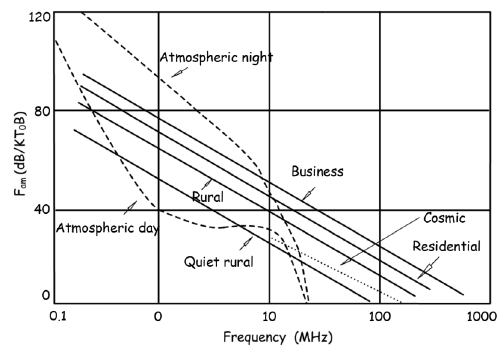
Fig. 10. Median values of man-made radio noise power (solid lines) expressed in terms of F am (dB above thermal noise at T 0 = 288 K). Atmospheric noise (dashed lines) and cosmic background noise (dotted line) are re- ported for comparison with man-made noise.